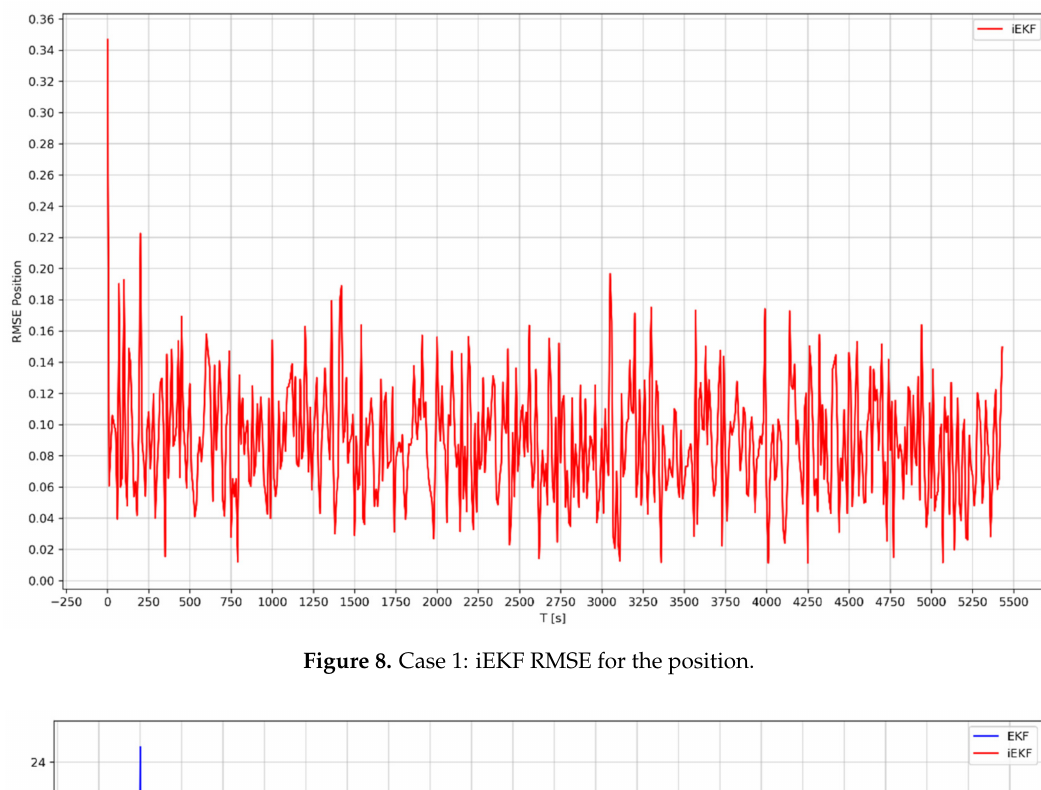
Figure 8. Case 1: iEKF RMSE for the position.